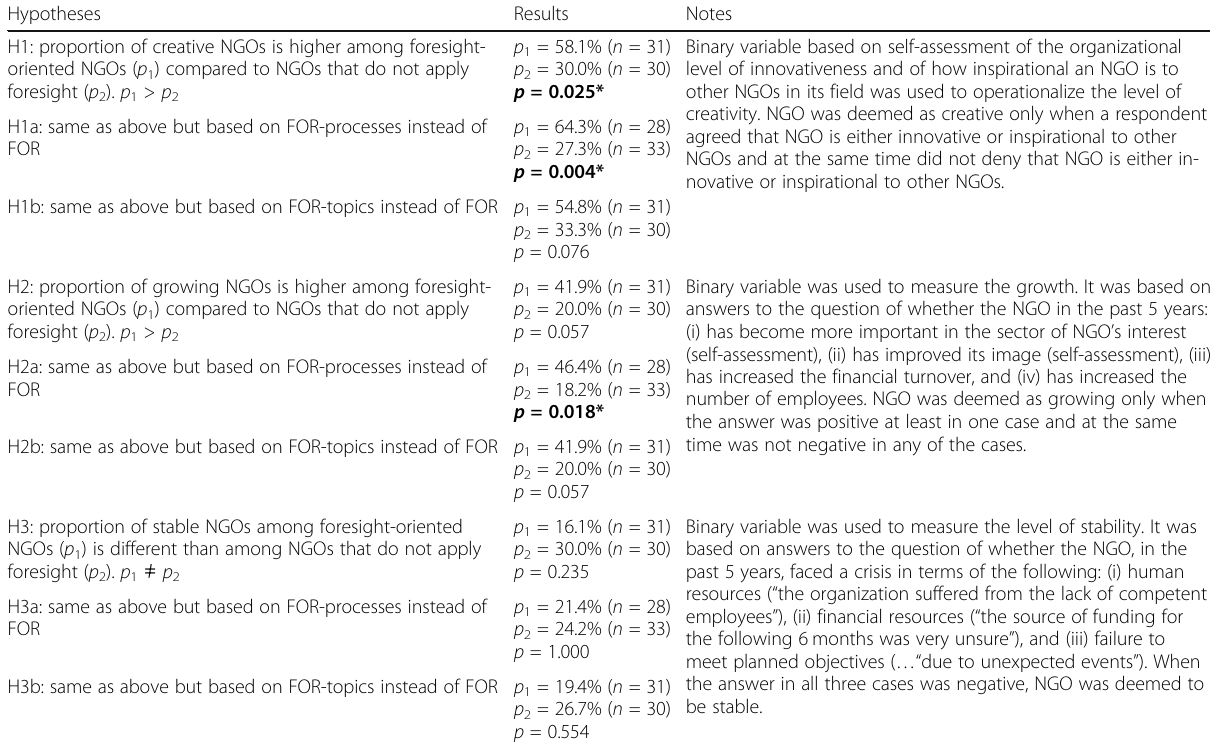
Table 3 Results of Fisher ’ s exact